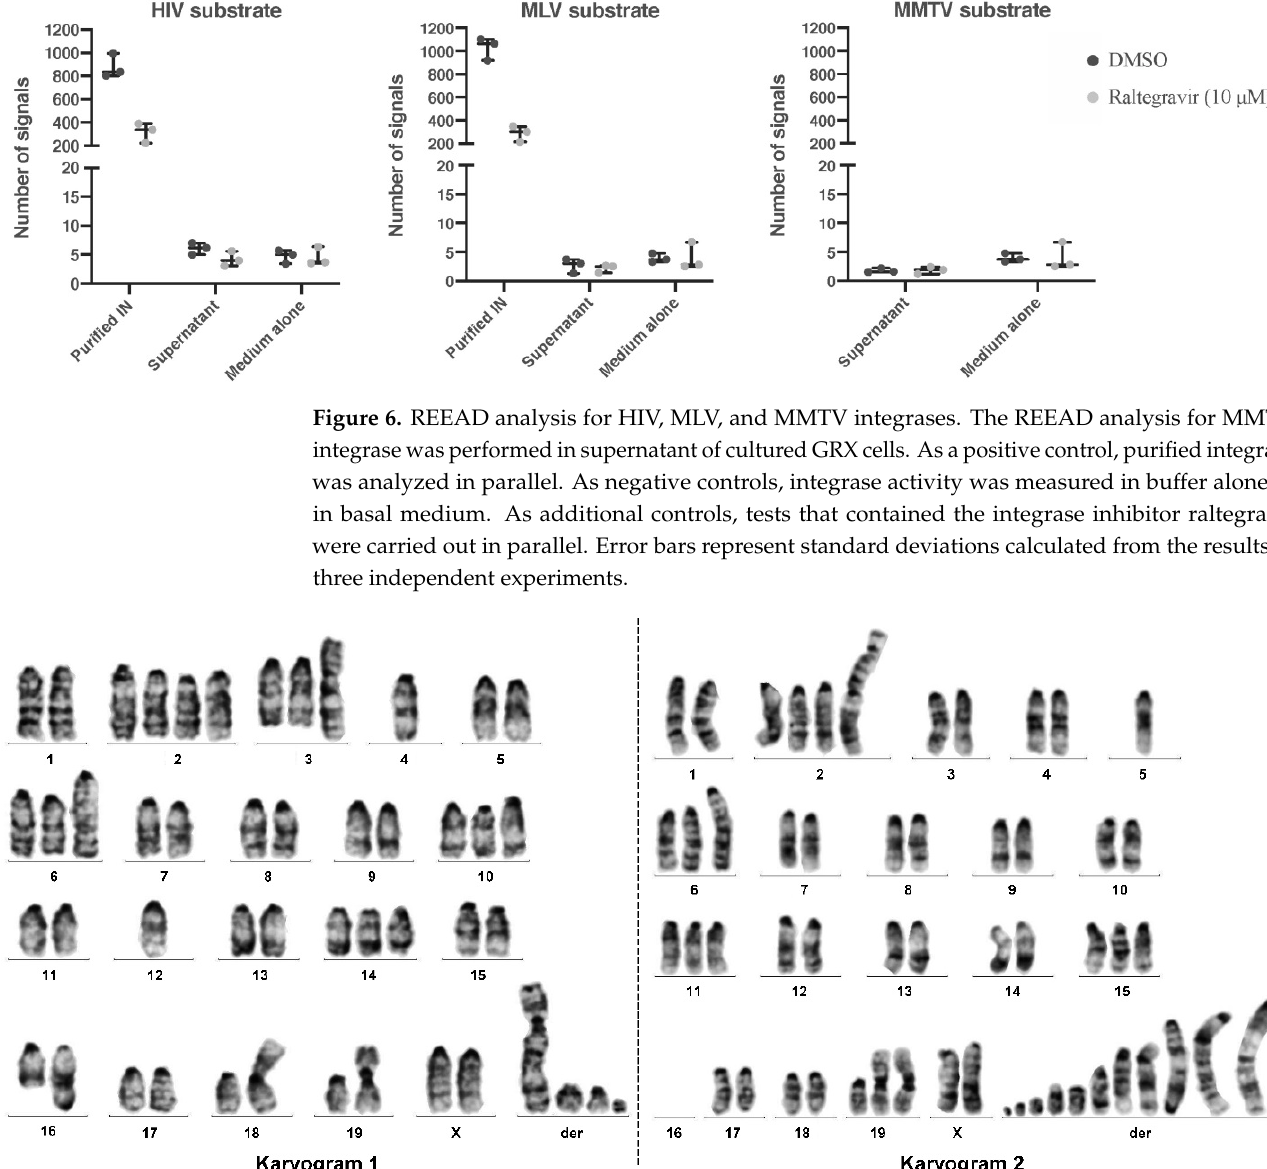
Figure 7. Representative karyograms found in GRX cells after Giemsa stain in light microscopic analysis.